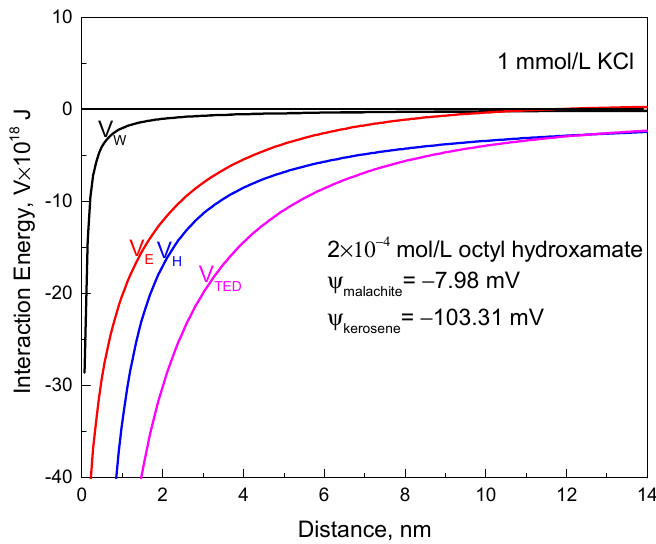
Figure 9. The interaction energy between malachite particles and emulsified kerosene droplets as a function of separation distance, malachite radius: 2.10 µm and kerosene radius: 1.07 µm.